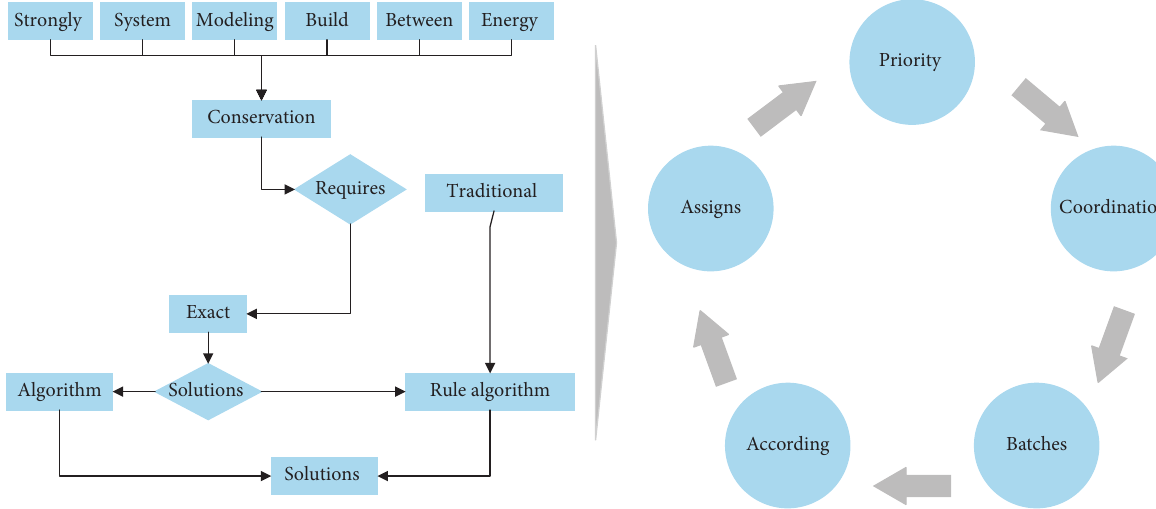
Figure 2: Model fusion